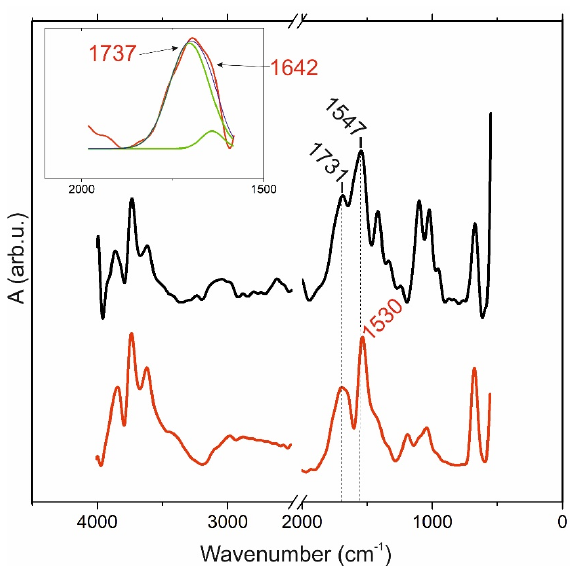
Figure 1. FTIR absorption spectra: black spectrum, powder of pectin with DE 0%; red spectrum, gel obtained from pectin 0 solution with a concentration of 1.25%. The selected area is the range of vibrations of carboxyl groups from the spectrum of the gel .